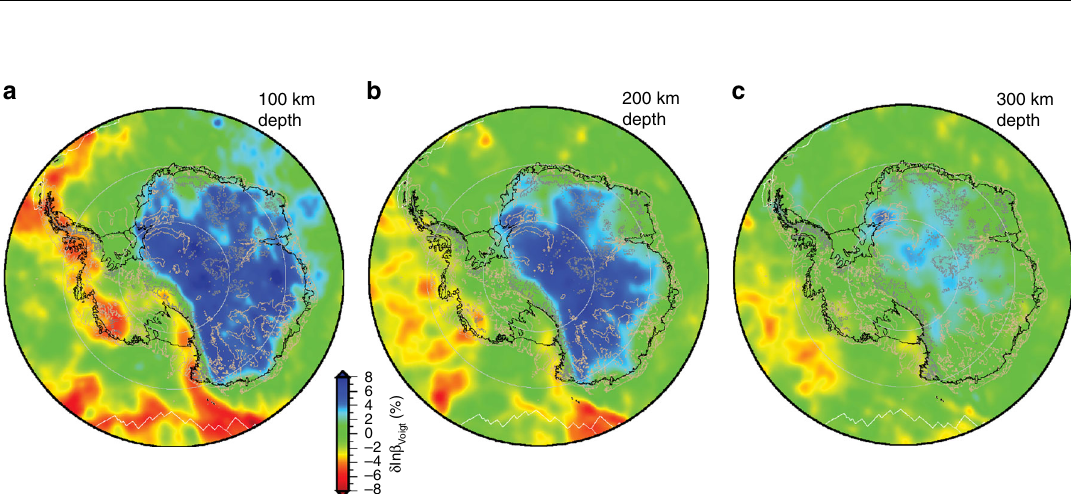
Fig. 3 Spatial variations in Earth properties in the upper mantle beneath Antarctica. Seismic shear wave velocity perturbations at depths of ( a ) 100, ( b ) 200 and ( c ) 300 km beneath Antarctica derived from an adjoint inversion of teleseismic waveforms recorded by seismic stations south of 45°S (ref. 52 ). Colours indicate observed Voigt average velocity anomalies relative to global reference model STW105 (ref. 147 ). Regions of negative anomalies